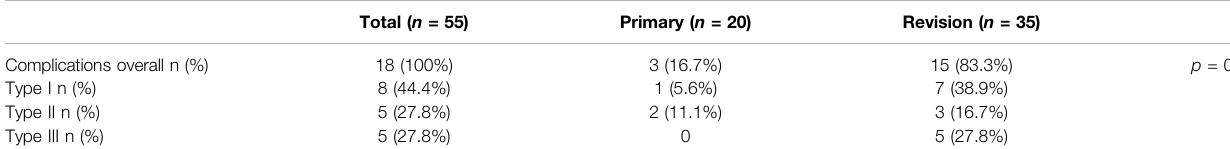
TABLE 3 | Complications that occurred after RH TKA in primary and revision cases.